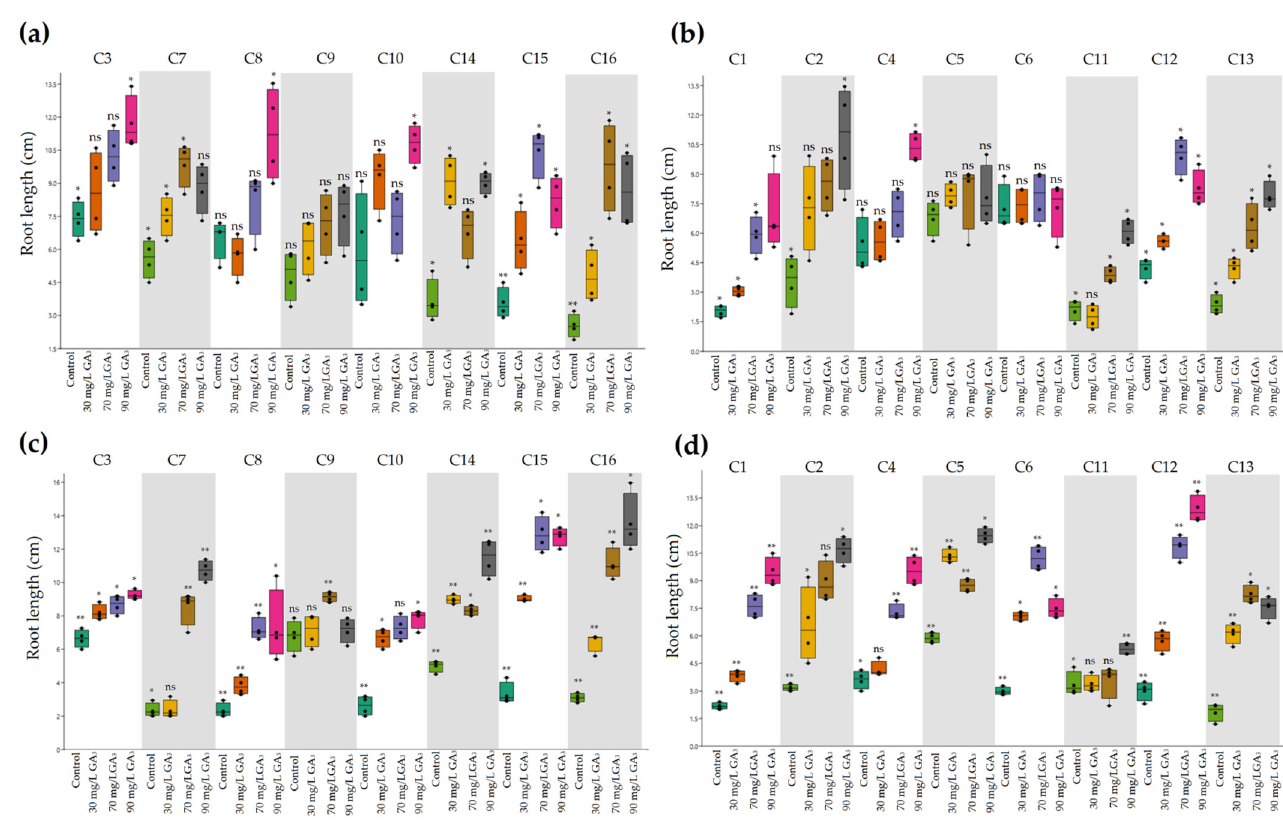
Figure 3. The effects of ambient temperature and high temperature stress and exogenously applied GA 3 on root length of heat-tolerant ( a , c ) and heat-sensitive ( b , d ) genotypes. * Significant at 5% probability level; ** significant at 1% probability level; ns, no significant difference.